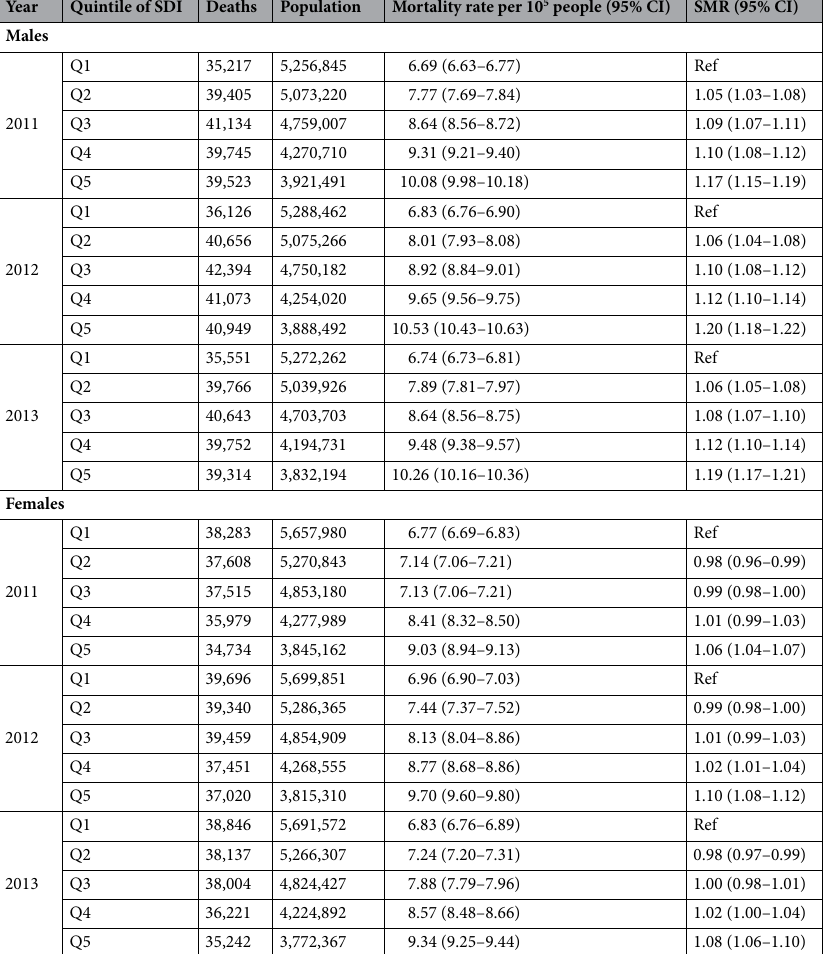
Table 1. Deaths, population, mortality rate, and standardized mortality rate with 95% confidence interval by sex, year and deprivation quintiles in Spain between 2011 to 2013. SDI Spanish Deprivation Index, Q deprivation quintiles, CI confidence interval, SMR standardized mortality rate (indirect